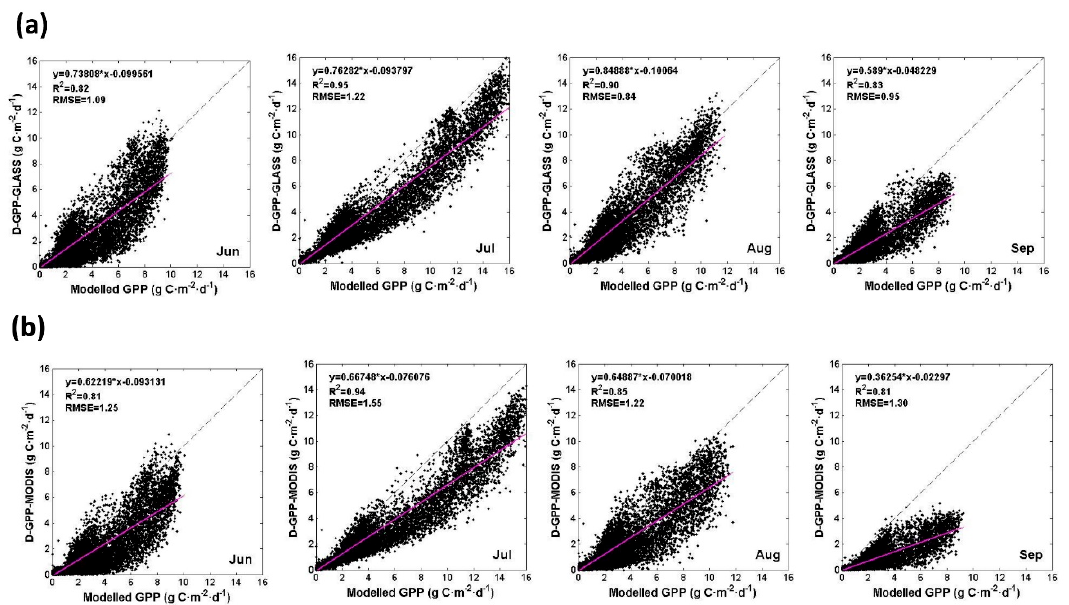
Figure 13. Cross validation of estimated GPP against high resolution GPP: ( a ) Comparison of D_GPP_GLASS and modelled GPP; ( b ) Comparison of D_GPP_MODIS and modelled GPP. GPP/NPP algorithm. D_GPP_GLASS means the GPP from downscaled FPAR/LAI based on